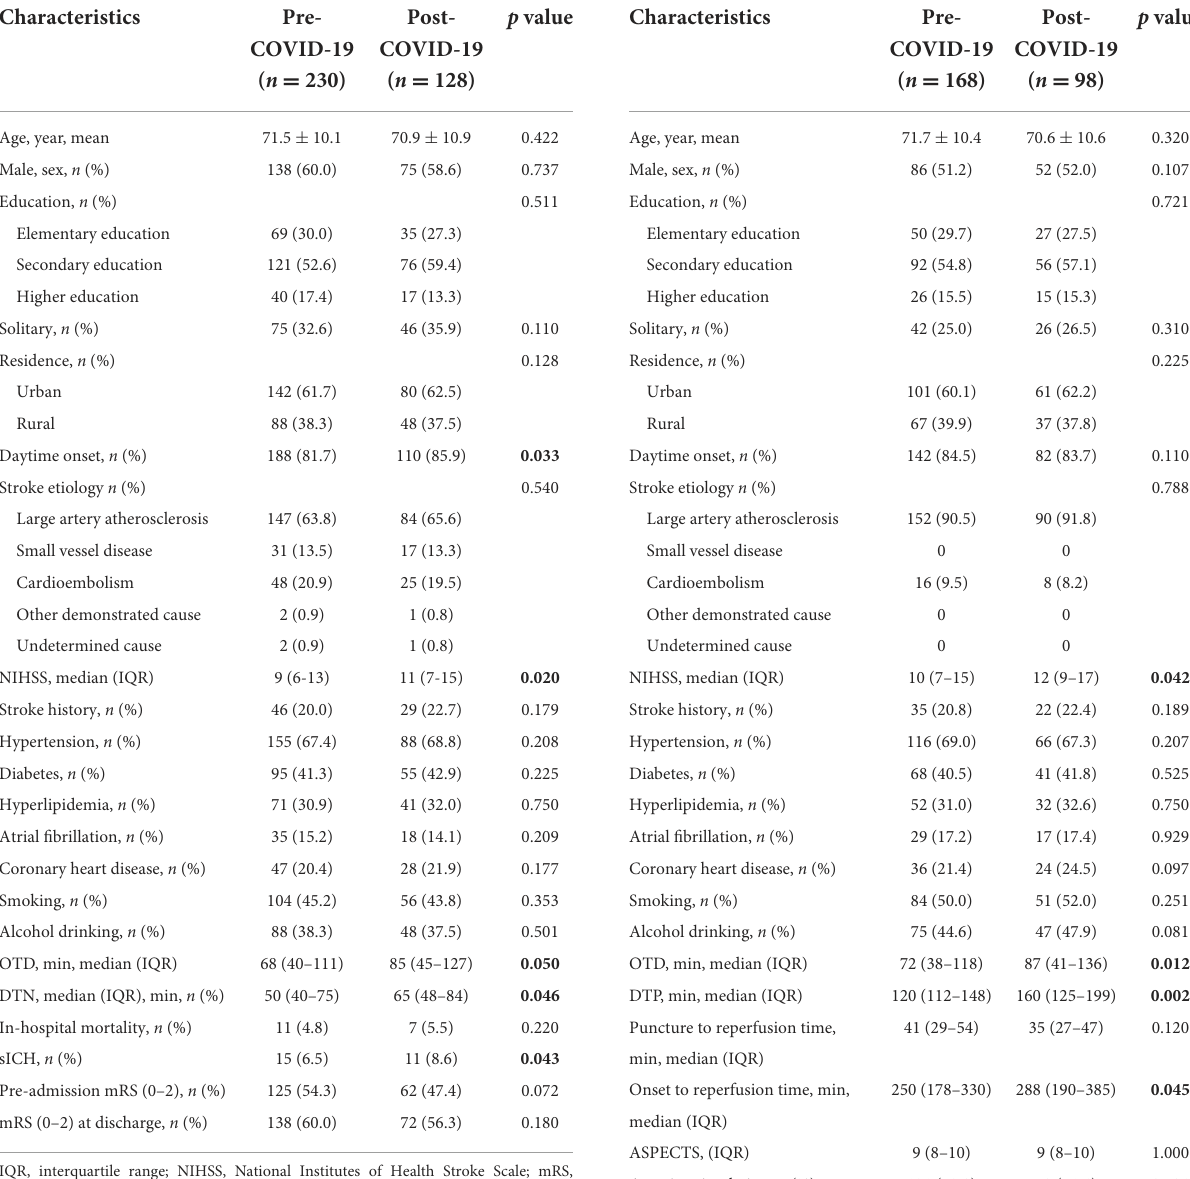
TABLE 1 Characteristics of acute ischemic stroke patients with intravenous thrombolysis treatment before and during the COVID-19 pandemic.